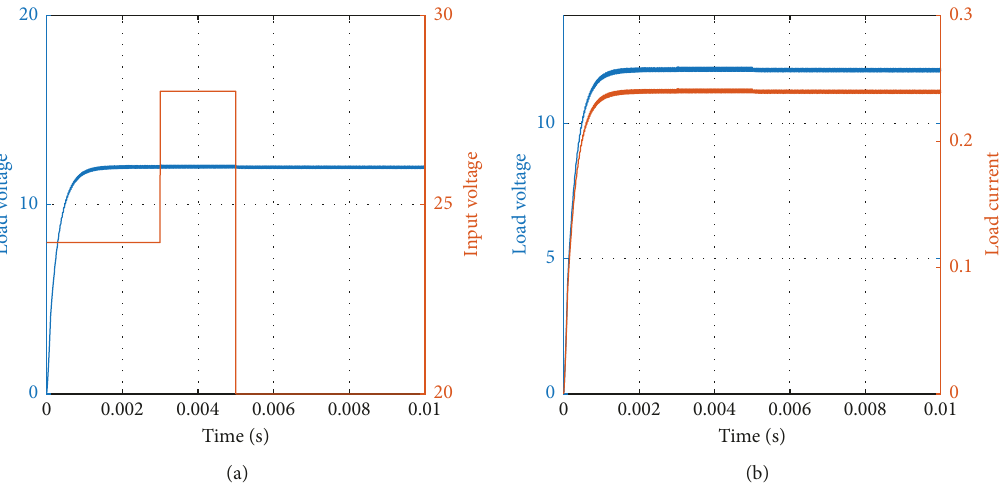
Figure 7: Plot for (a) output load voltage and the variable input voltage and (b) output current and voltage for varying input voltage case using flower pollination algorithm-tuned QFT